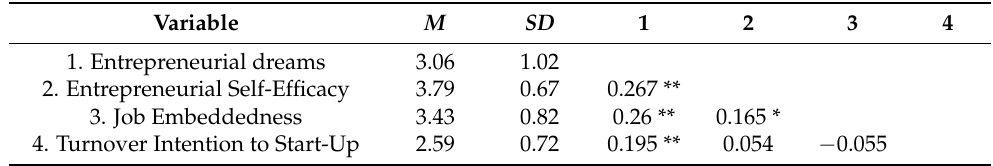
Table 2. Descriptive Statistics: Means, Standard Deviations, and Correlations Among